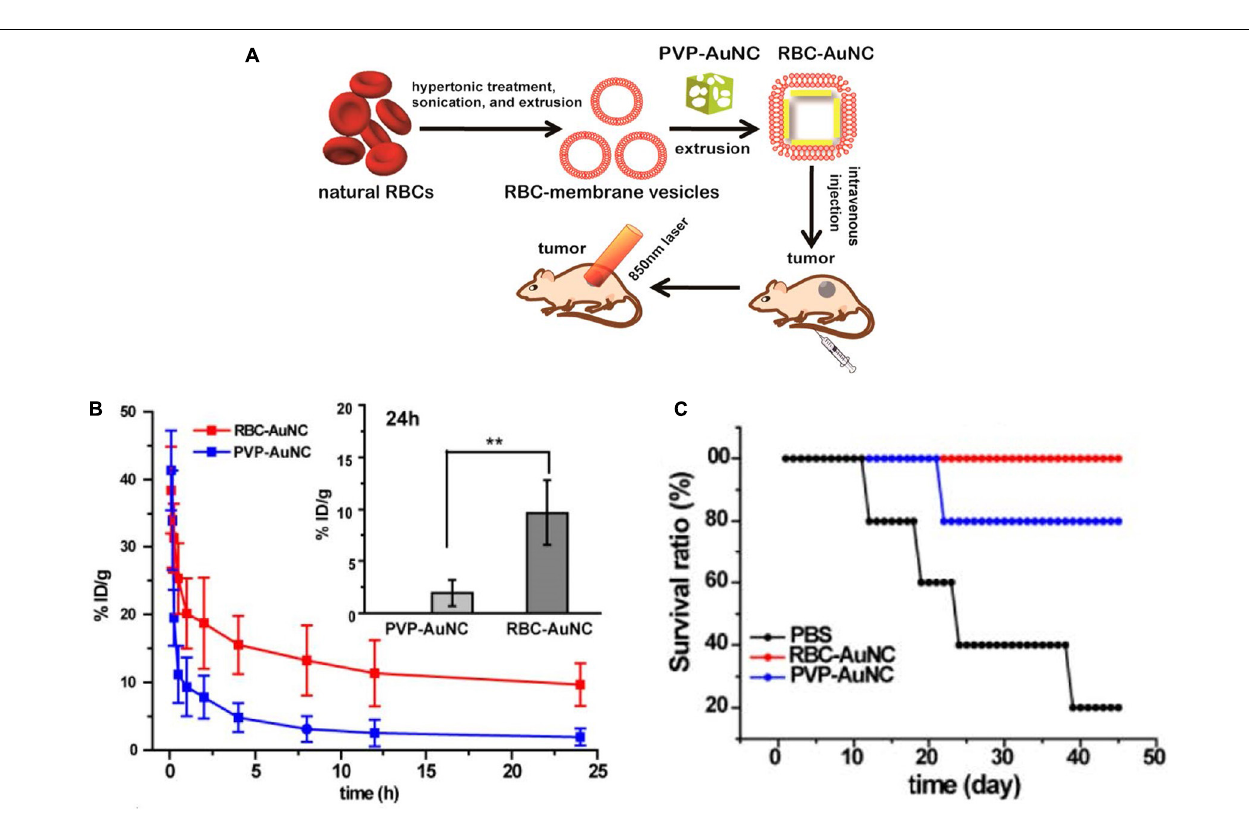
FIGURE 6 | (A) Schematic demonstrating the preparation of RBC-AuNCs. (B) The RBC-AuNCs retained longer in blood than the pristine PVP-AuNCs in mice. ** P < 0.01. (C) The survival time of the RBC-AuNCs group was longer than that of PVP-AuNCs and PBS group. Reprinted with permission from Piao et al. (2014), Copyright (2014), American Chemical